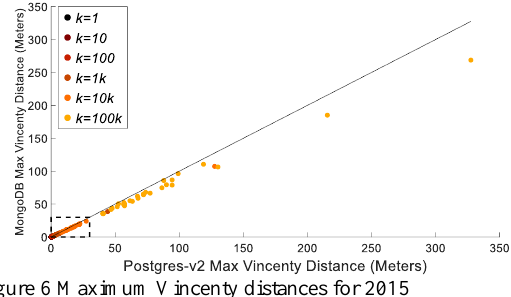
Figure 6 Maximum Vincenty distances for 2015